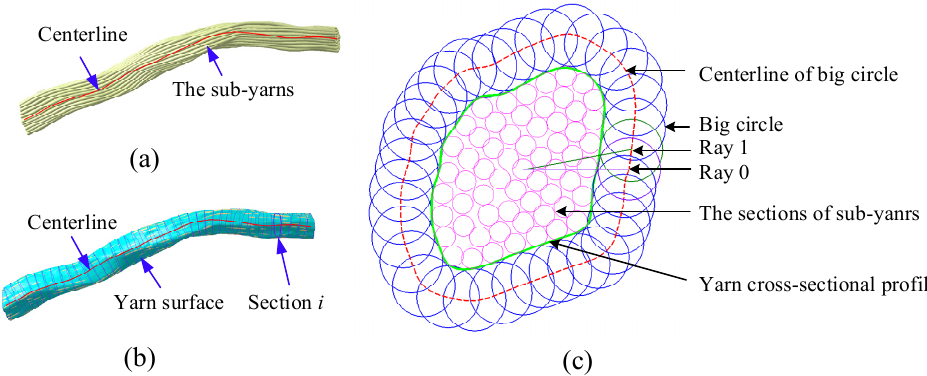
Figure 10. Illustration of the yarn geometry extraction process: ( a ) the fiber-level geometry from yarn deformation simulation, ( b ) the yarn geometry, and ( c ) the process of section profile extraction.